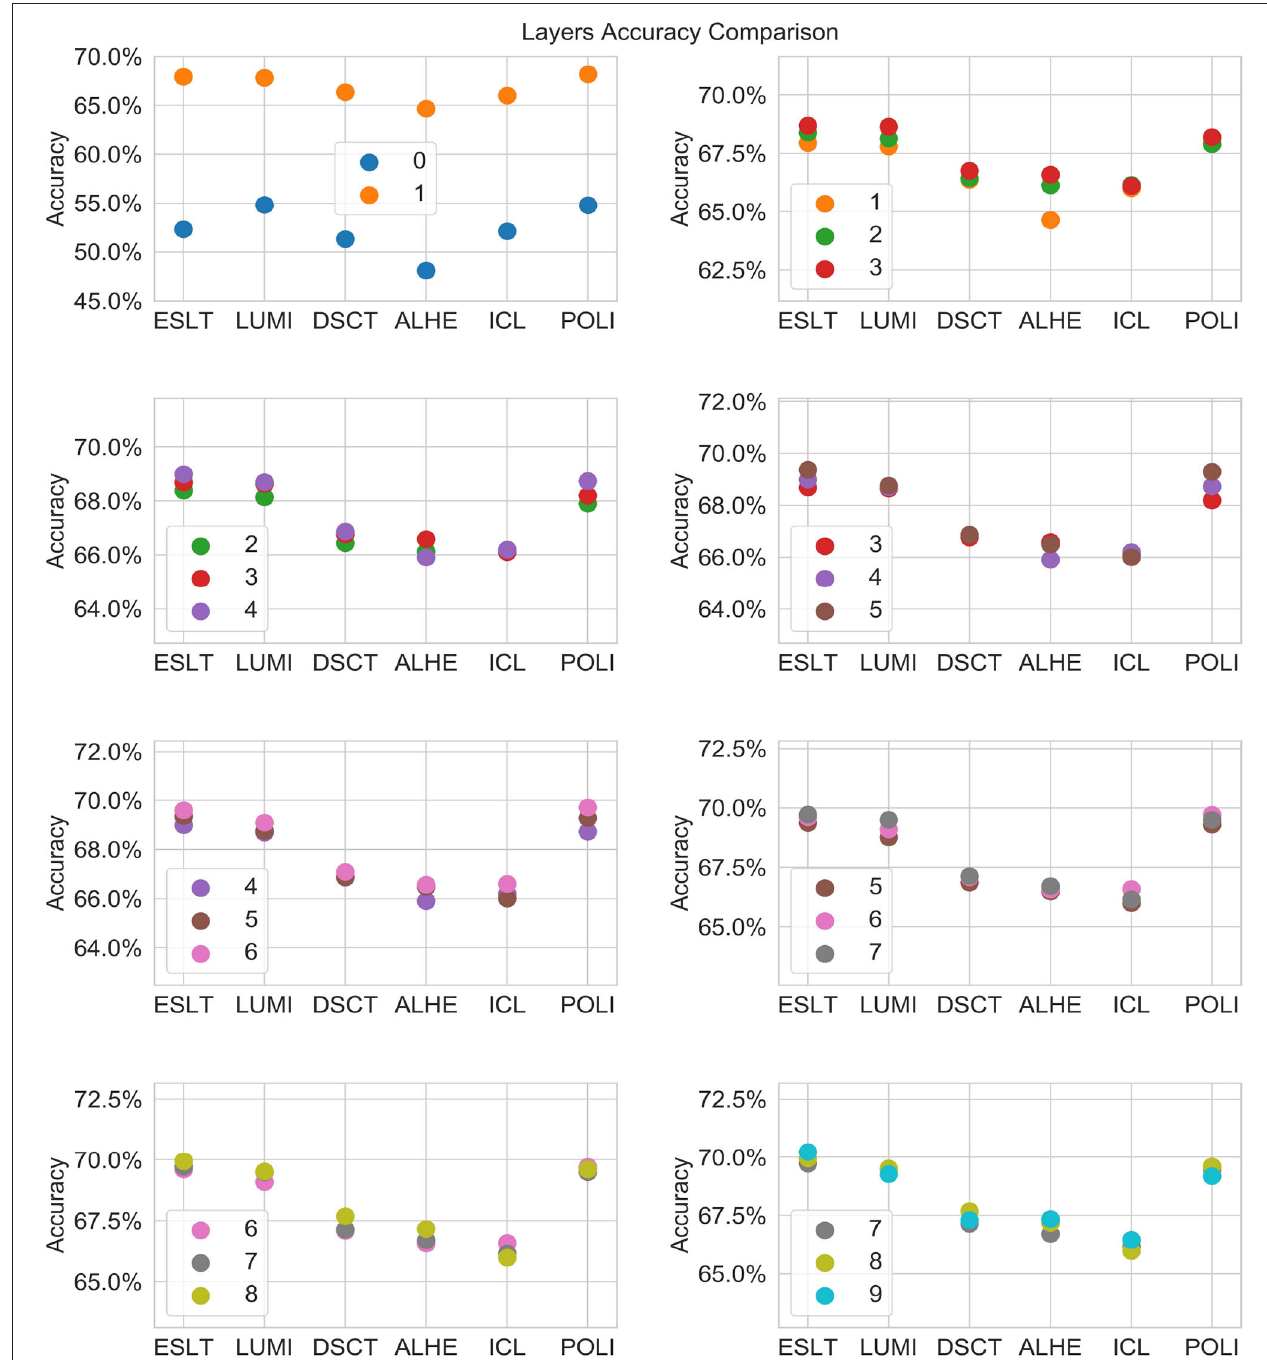
FIGURE 4 | Prediction accuracy by number of layers and